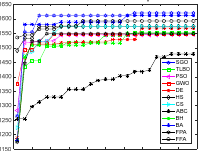
“ − ”, “ + ” and “ ≈ ” denote that performance of algorithms are worse, better and similar to BSGO respectively